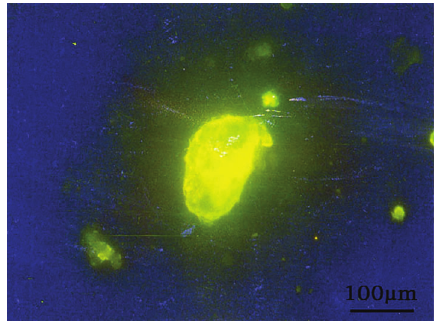
Figure 6. Tetracycline labeling for fi broblasts induced with 40 m g/mL fi bronectin showing golden nodules, which had a trabecula-like structure. Fluorescence microscope, (cid:1)